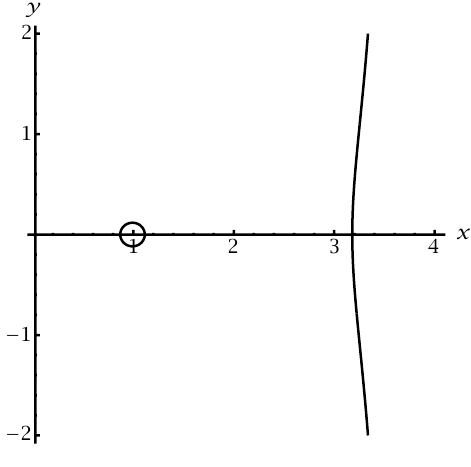
Figure 3.1 . | (z − 2 ) 3 | = | (z − 1 )(z − 4 ) 2 |